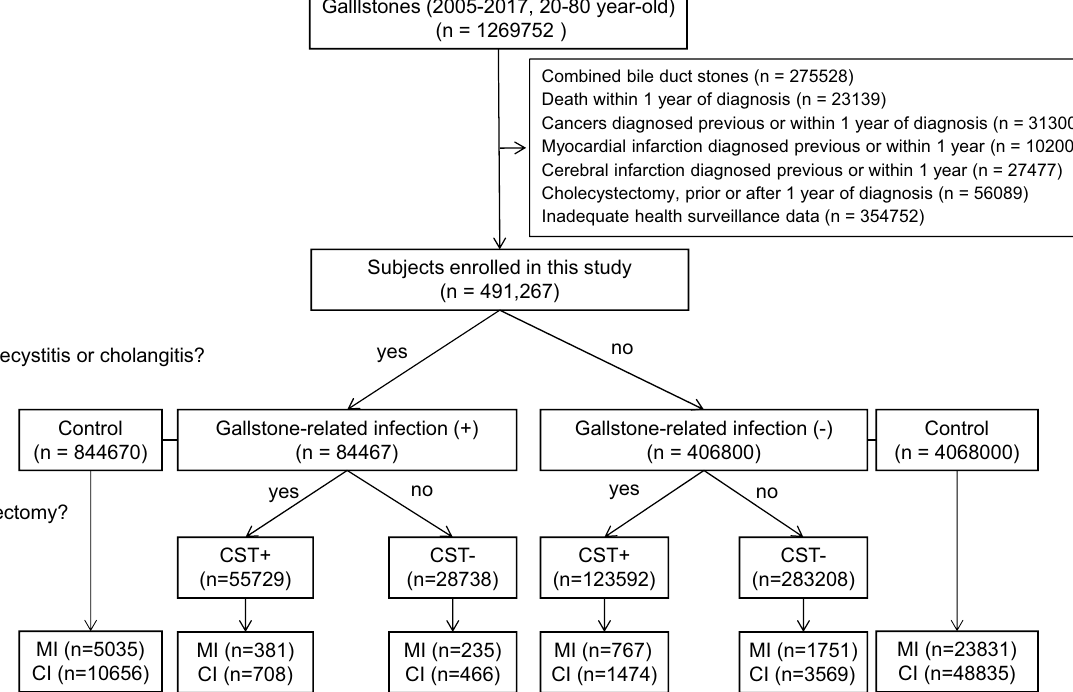
Figure 1. Flow chart of the study. MI, myocardial infarction; CI, cerebral infarction; CST,